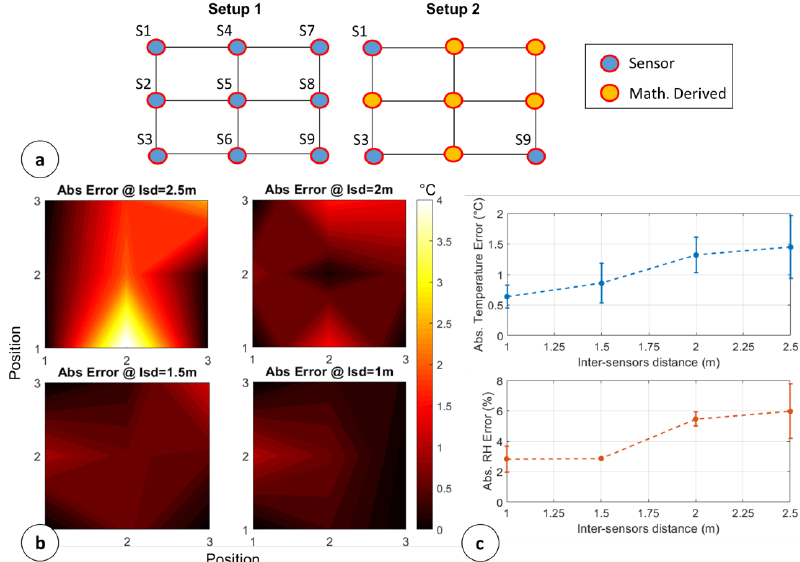
Figure 8. Absolute errors considering mathematically derived values: ( a ) ground truth setup (Setup1) vs. mathematically derived setup ( b ) absolute temperature errors with variable Isd ( c ) average and standard deviations of temperature and RH errors vs Isd.